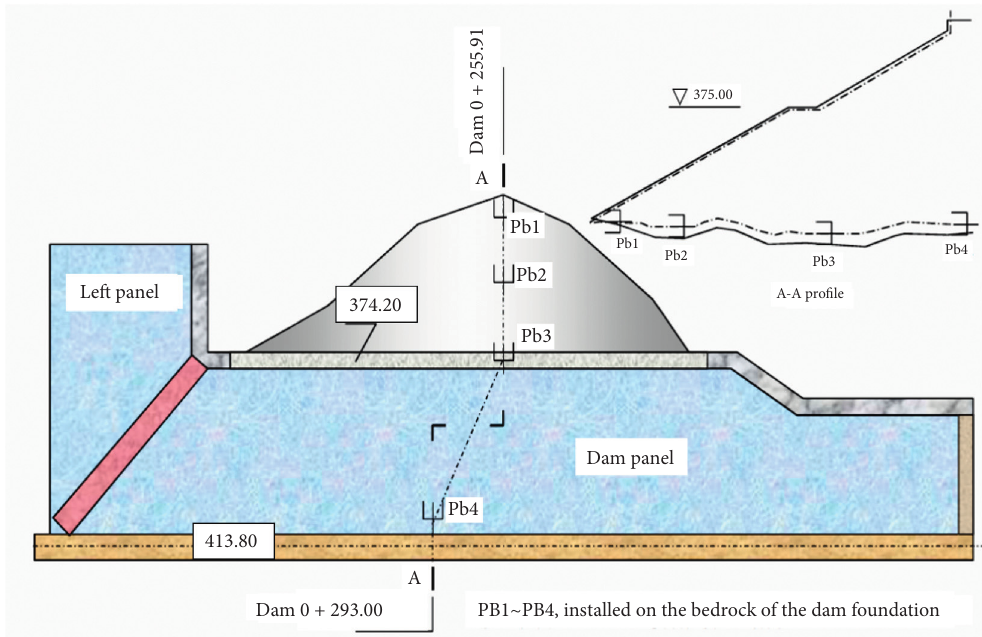
Figure 1: Arrangement of seepage pressure measuring instruments for dam